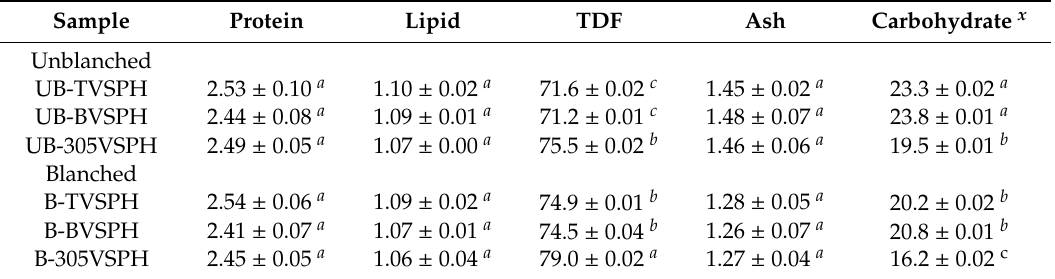
Table 1. Proximate composition of the unblanched and blanched vegetable soybean pod hull w (% dry wt.). Sample Protein